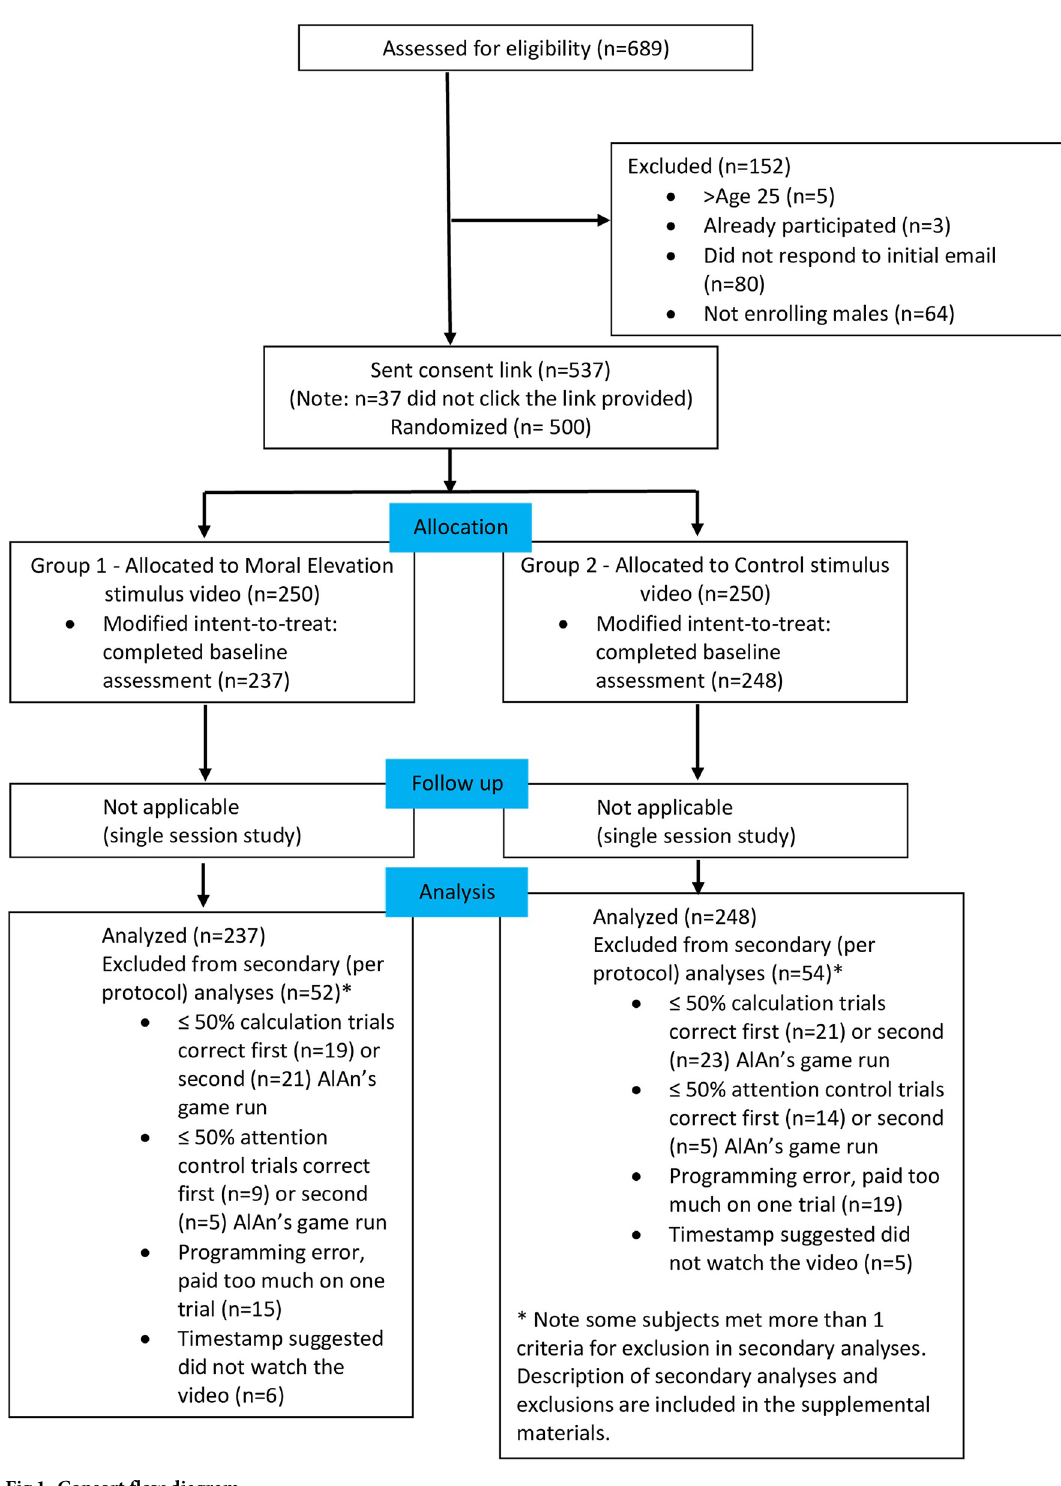
Fig 1. Consort flow